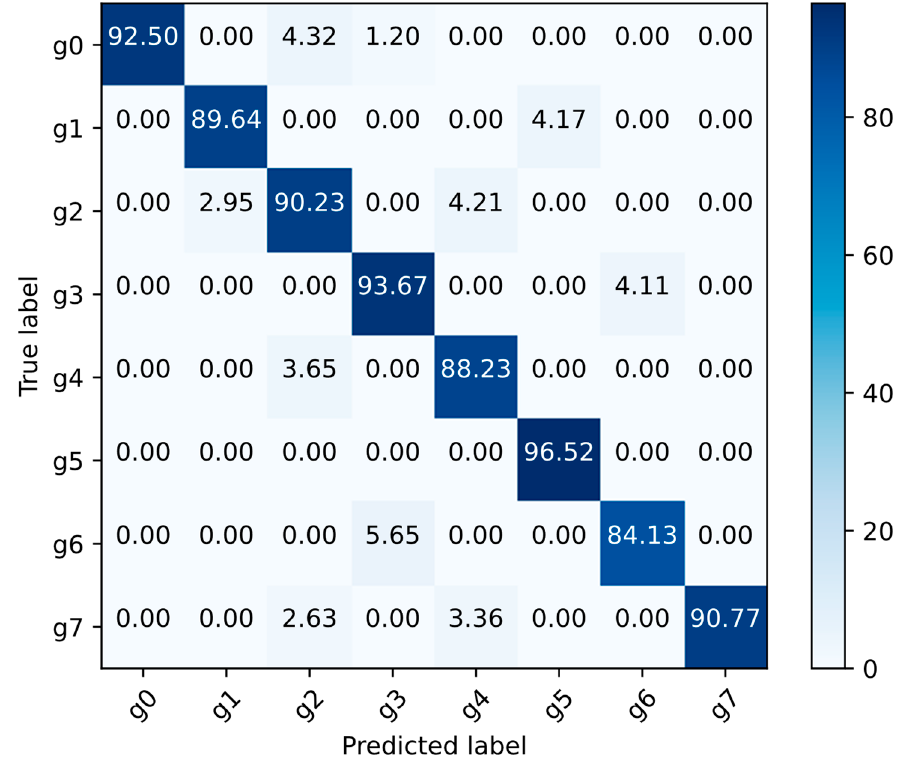
Figure 7. Confusion matrix of results on the self-built